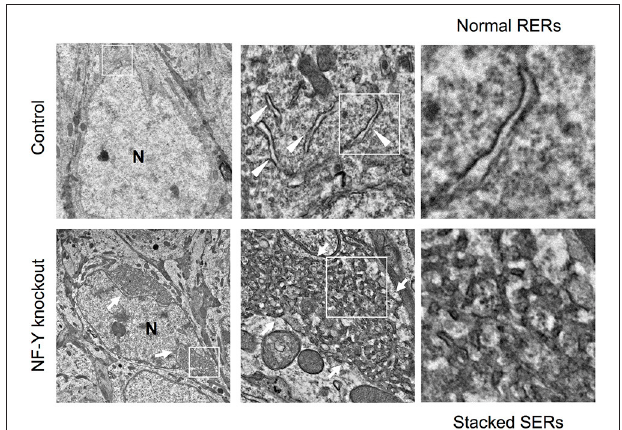
FIGURE 4 | SER pathology in NF-Y knockout neurons. Electron microgram of hippocampal CA1 neurons in control and NF-Y knockout mouse. Boxed areas are enlarged in the next panels. The neurons of NF-Y knockout mouse contain stacked SERs at perinuclear regions (arrows in lower panels) whereas control mouse neurons contain normal RERs (arrowheads in upper panels). N indicates nucleus. The data are reproduced from our previous paper ( Yamanaka et al., 2014) with slight